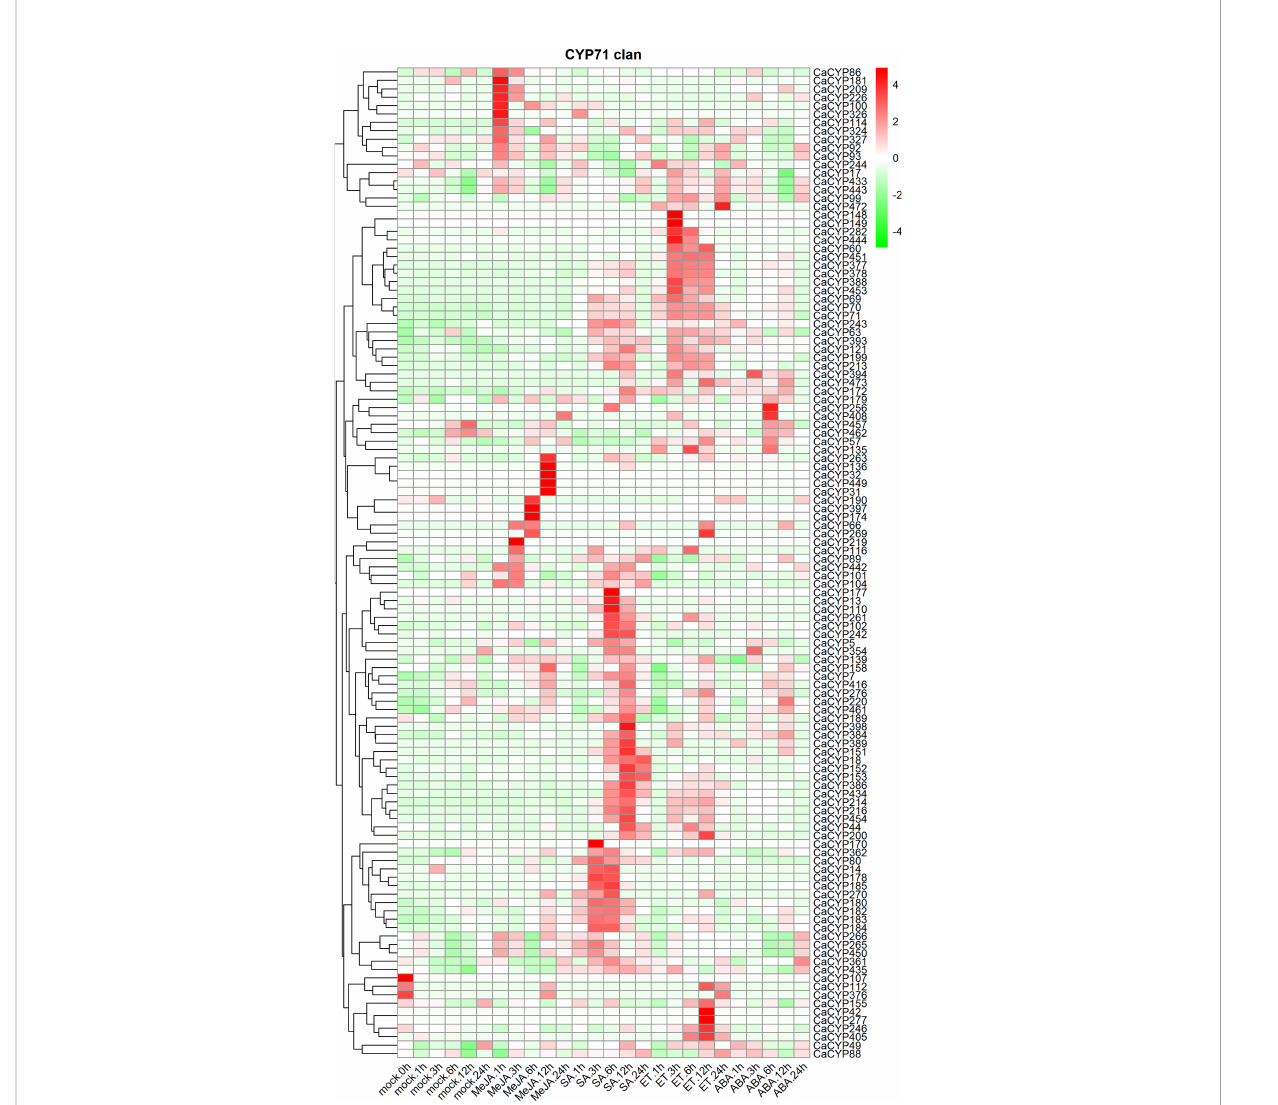
FIGURE 8 Analysis of the expression patterns of the selected CaCYP genes in different phytohormone treatments. Heatmaps of normalized RNA-seq data prepared from three biological replicates. The high-expression level is marked by red color, and the low-expression level is marked by green color. Expression levels after phytohormone treatment, including methyl jasmonate (MeJA), salicylic acid (SA), ethylene (ET), and abscisic acid (ABA). Different time points include 1, 3, 6, 12, and 24 h. The control group is represented by the Mock